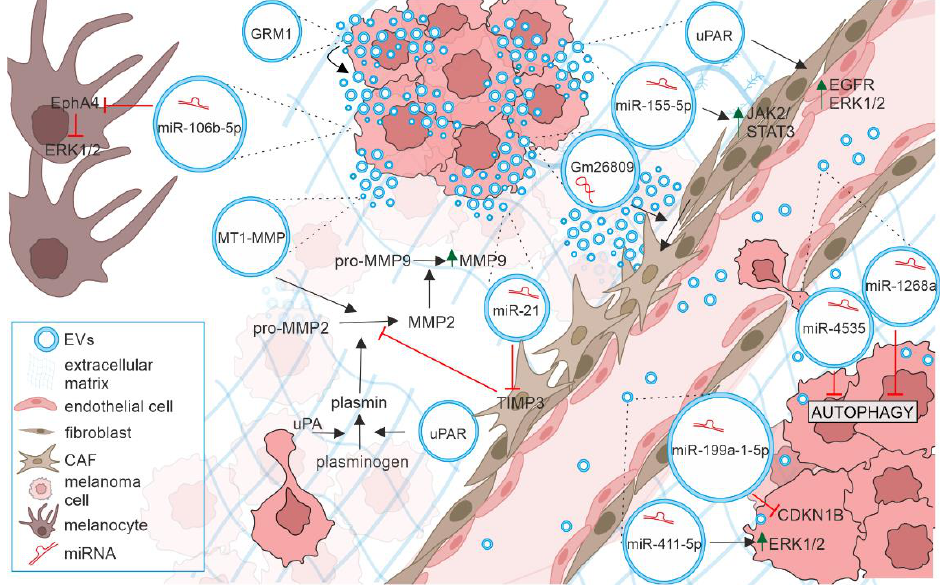
Figure 2. The role of extracellular vesicles in progression of melanoma. EVs (blue circles) released by melanoma cells can transfer their cargo such as miRNAs and proteins to various recipient cells. By modifying functions of melanocytes, other melanoma cells, stromal cells, and immune cells they contribute to all steps of metastasis including extracellular matrix remodeling, angiogenesis, pre-metastatic niche formation and proliferative colonization of distant organs. See text for details.